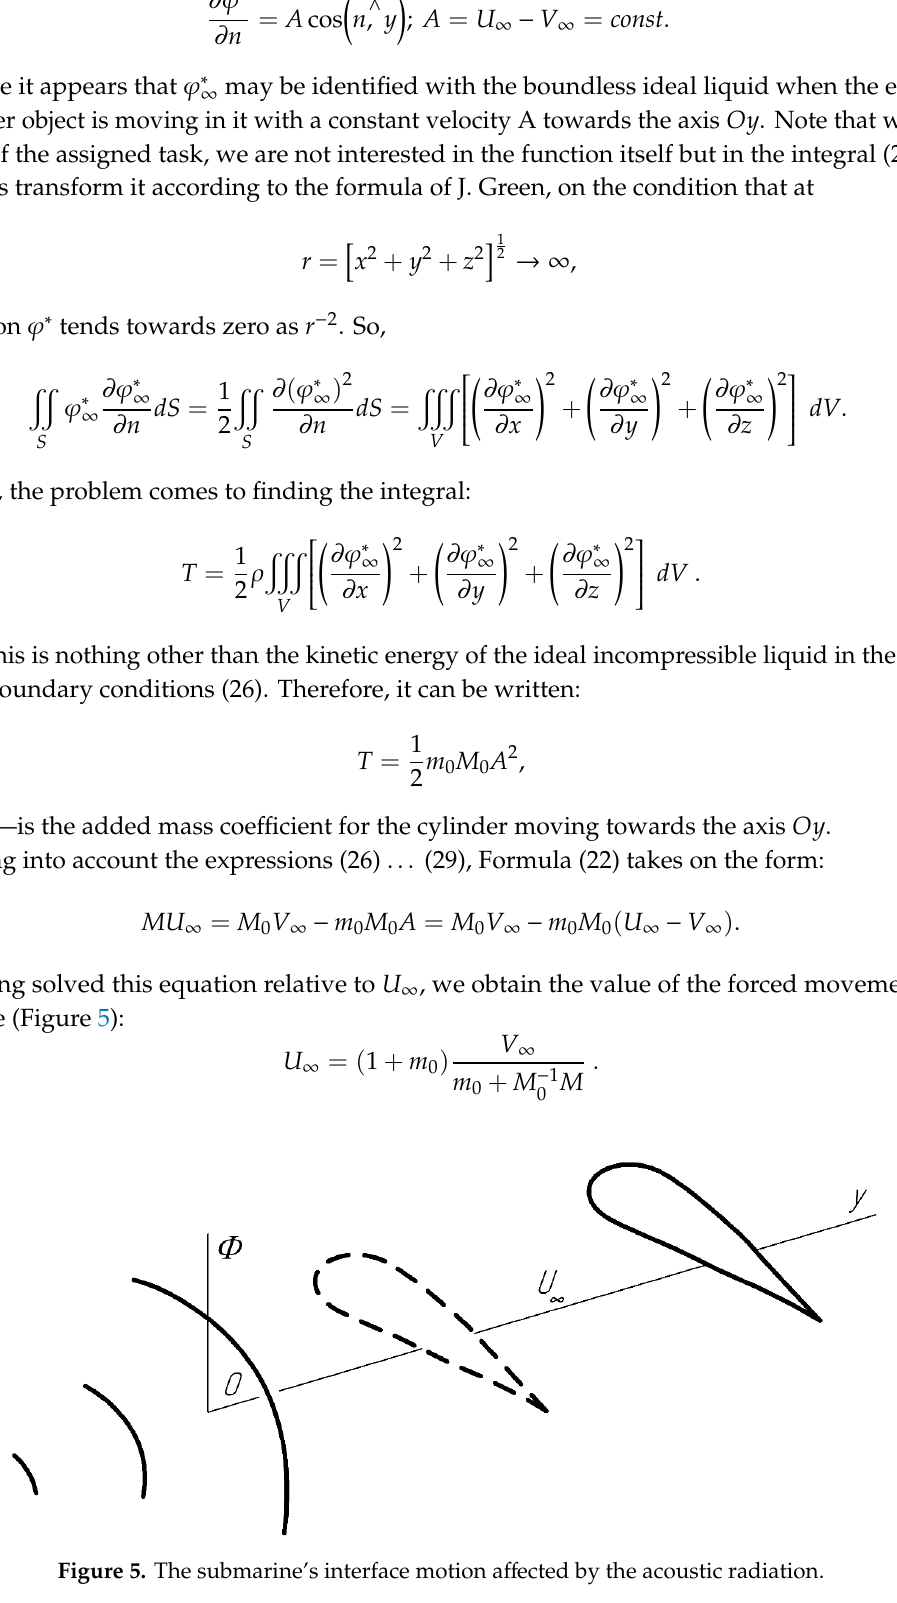
Figure 5. The submarine’s interface motion affected by the acoustic radiation.